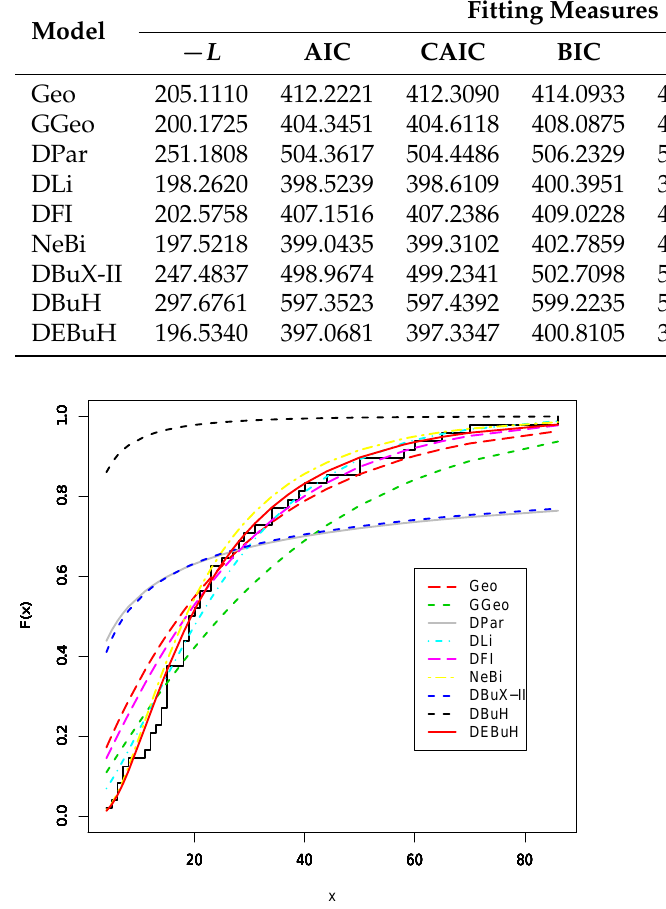
Figure 9. Estimated CDFs of the DEBuH model and other discrete models for data set